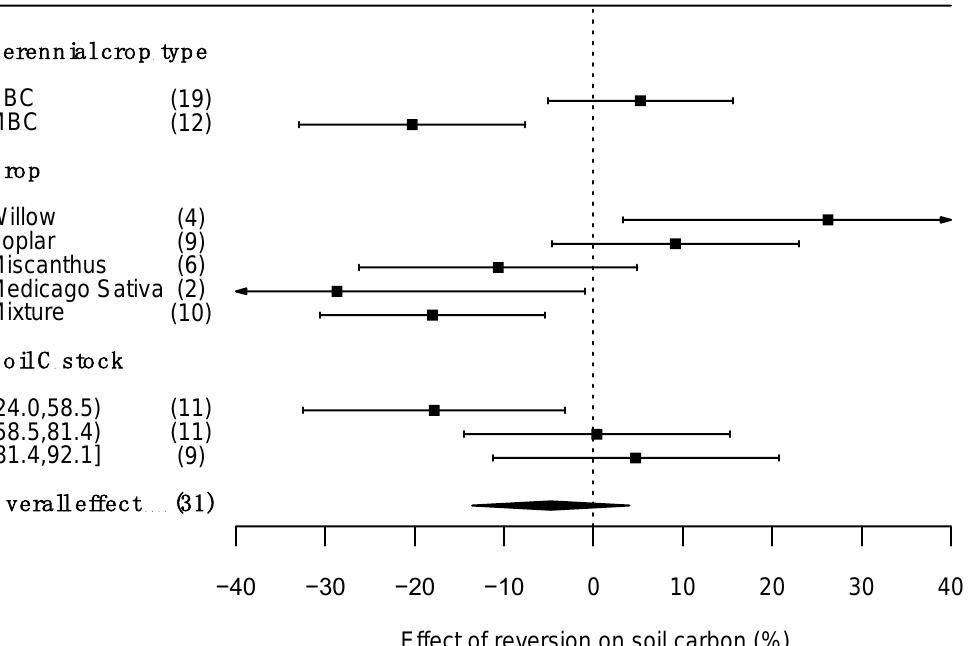
Figure 2. Percentage change of soil organic carbon (Mg SOC ha − 1 ) after the reversion of perennial crops according to perennial crop type (PBCs and MBCs), crop species or soil carbon stock in the 0–30 cm layer (Mg C ha − 1 ). Error bars represent the 95% confidence intervals. Parenthesis indicates the number of observations used to calculate the effect size.